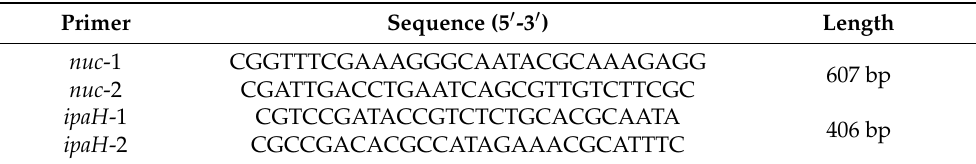
Table 2. The primers of nuc and ipaH